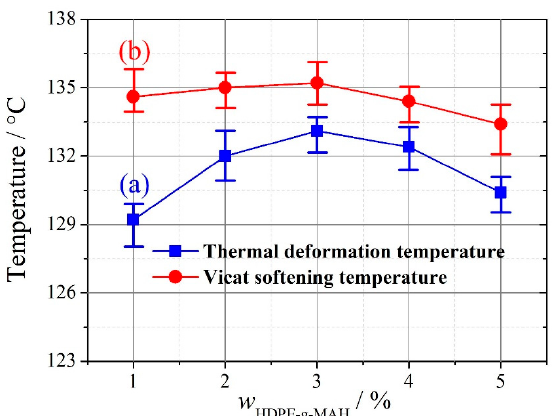
Figure 8. Thermal deformation temperature and Vicat softening temperature of OMMT-modified UHMWPE with increasing amounts of HDPE-g-MAH. ( a ) Thermal deformation temperature, ( b ) Vicat softening temperature (repeated three